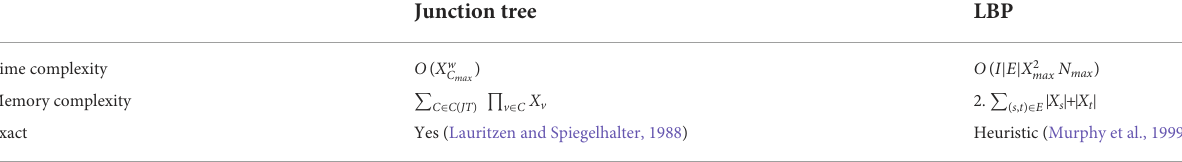
Figure 7, showing runtime and memory consumption for MRFs with increasing number of